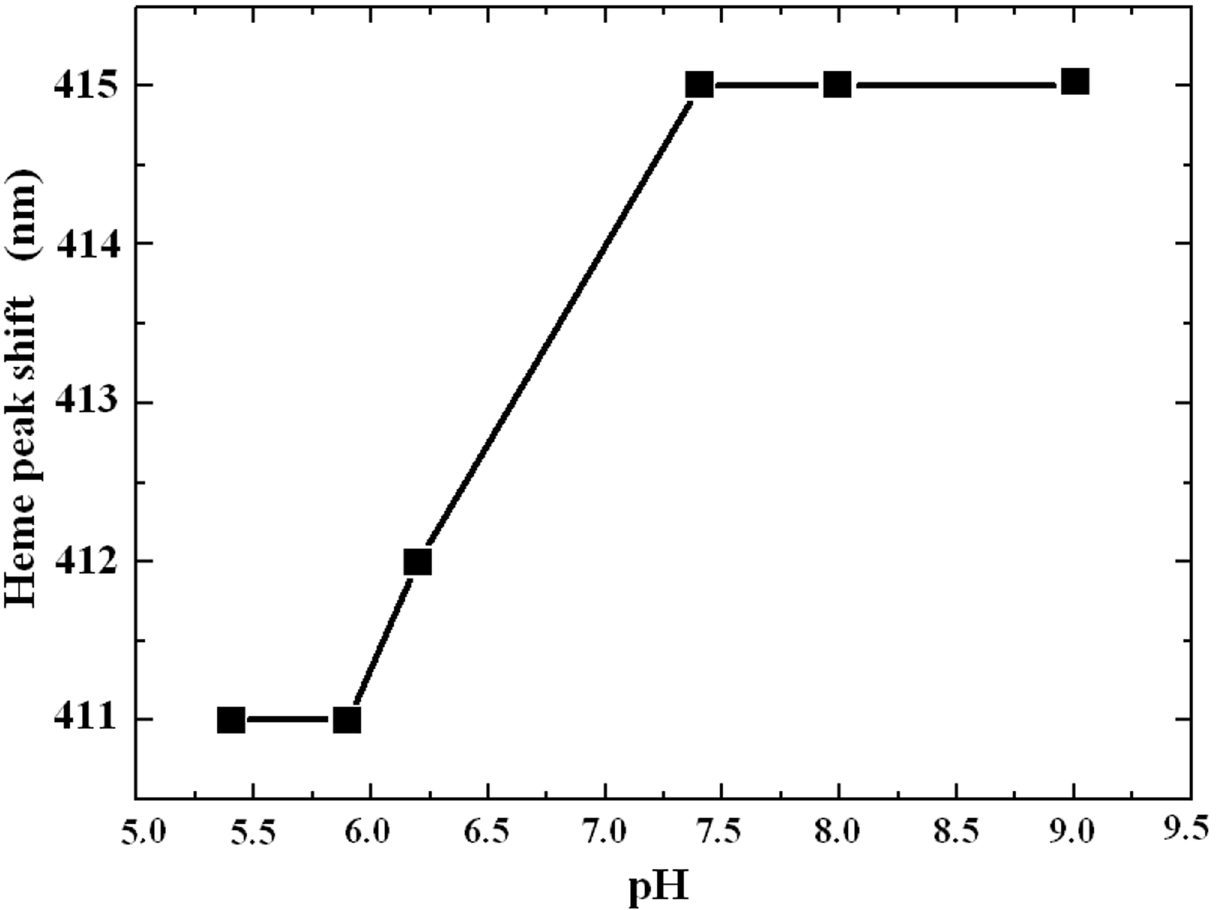
Figure 3. The shift of the heme absorption peak under different pH